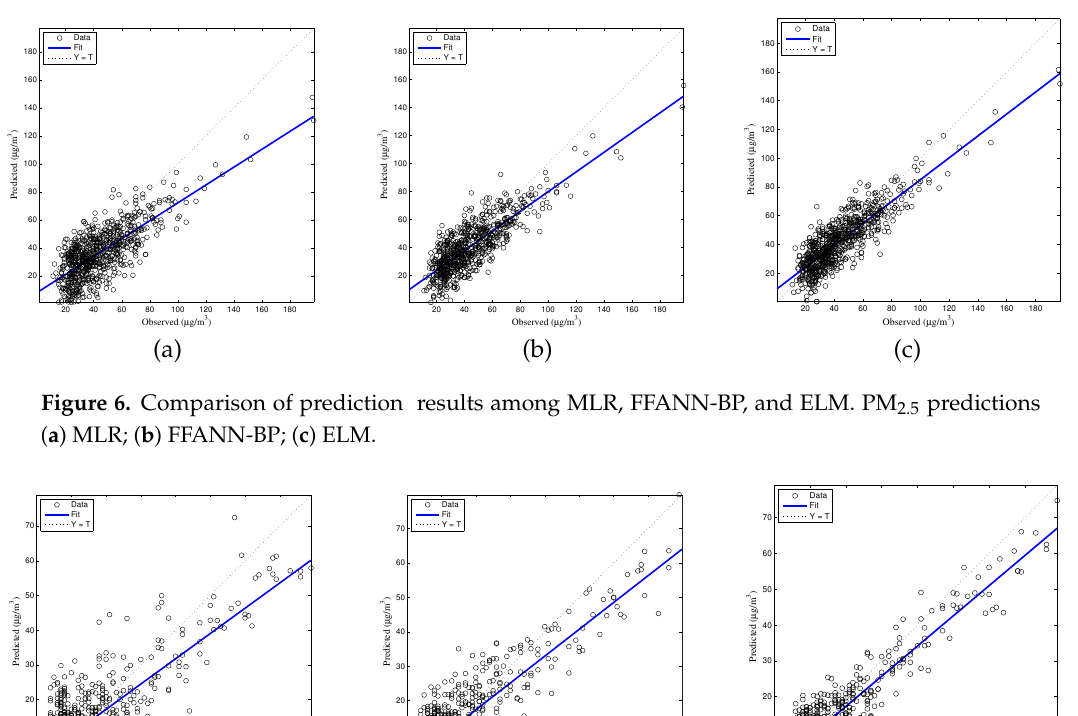
Figure 5. Comparison of prediction results among MLR, FFANN-BP, and ELM. O 3 predictions ( a ) MLR; ( b ) FFANN-BP; ( c ) ELM.